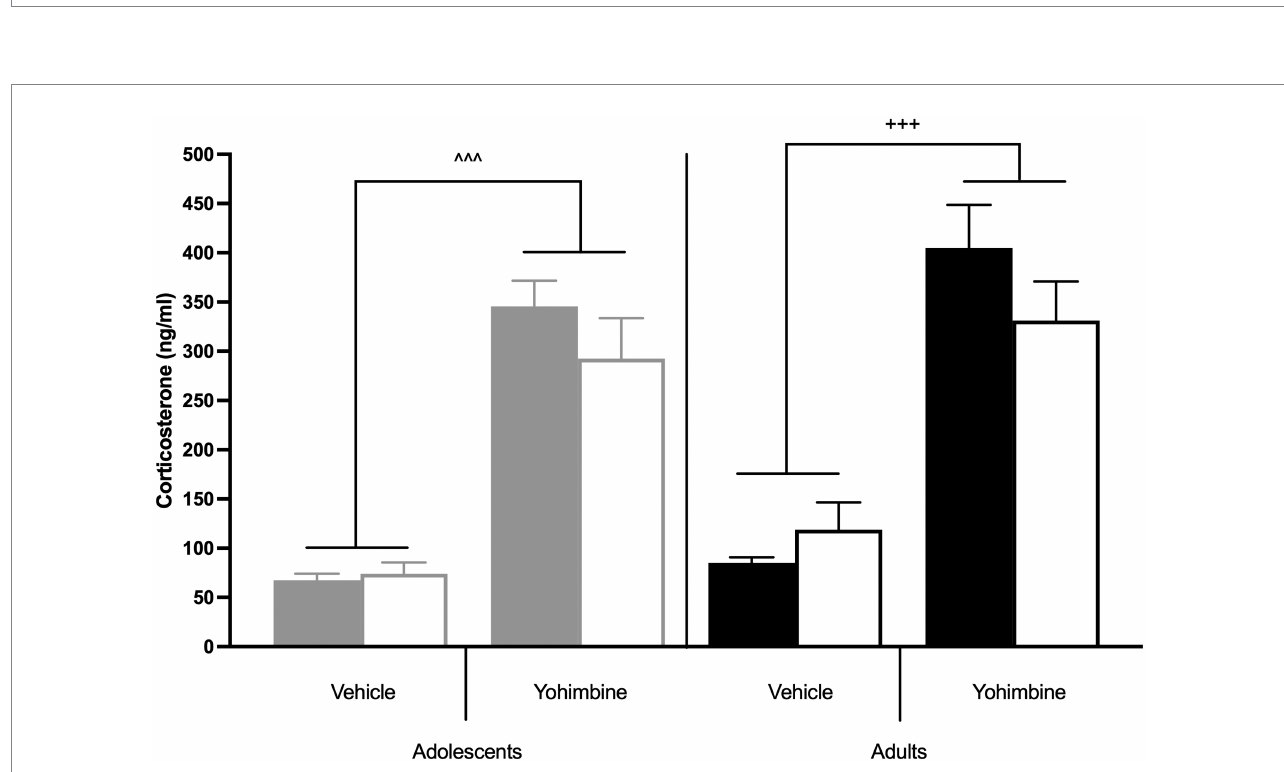
FIGURE 6 Yohimbine-induced HPA axis activation in behaviorally tested animals. The bars represent mean (±SEM) corticosterone levels after yohimbine or vehicle injections in adolescent (gray bars) and adult (black bars) rats that underwent stress-induced reinstatement of CSE- (solid) or nicotine-seeking (hashed). ^^^ p < 0.0001 vs. vehicle, adolescents; +++ p < 0.0001 vs. vehicle, adults. n = 4–6 per